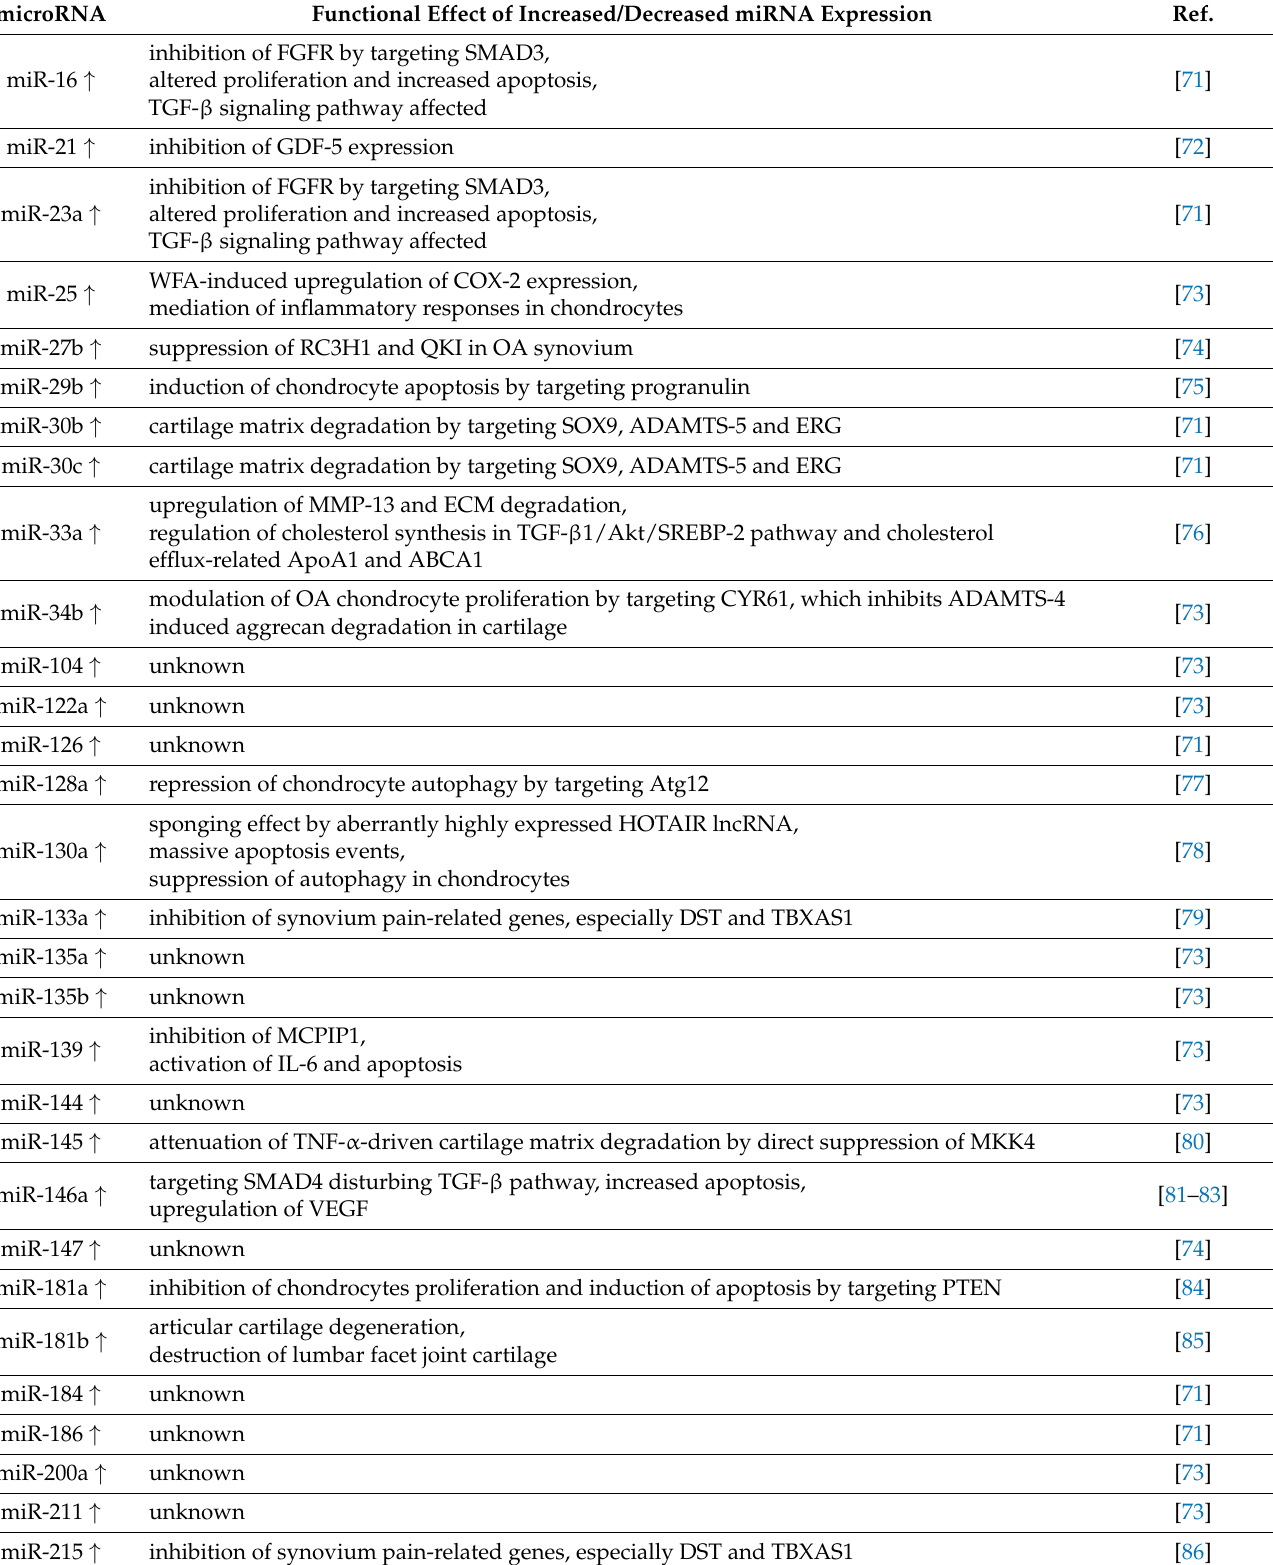
Table 1. Summary of miRNAs which are differentially expressed in